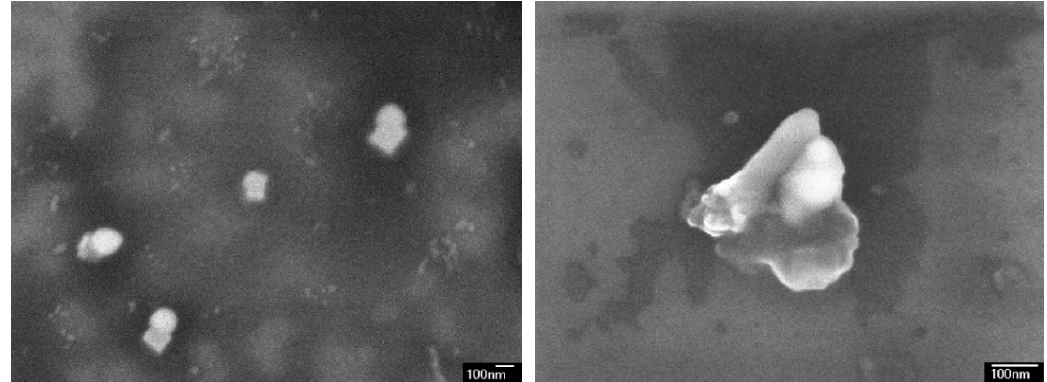
Figure 6. Micrographs of homo ‐ ( a ) and heteroaggregates ( b ) of ZnO NPs in the soil leachate.